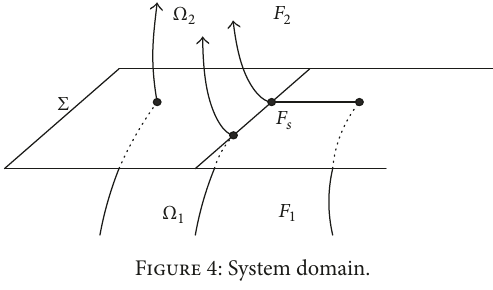
Figure 4: System